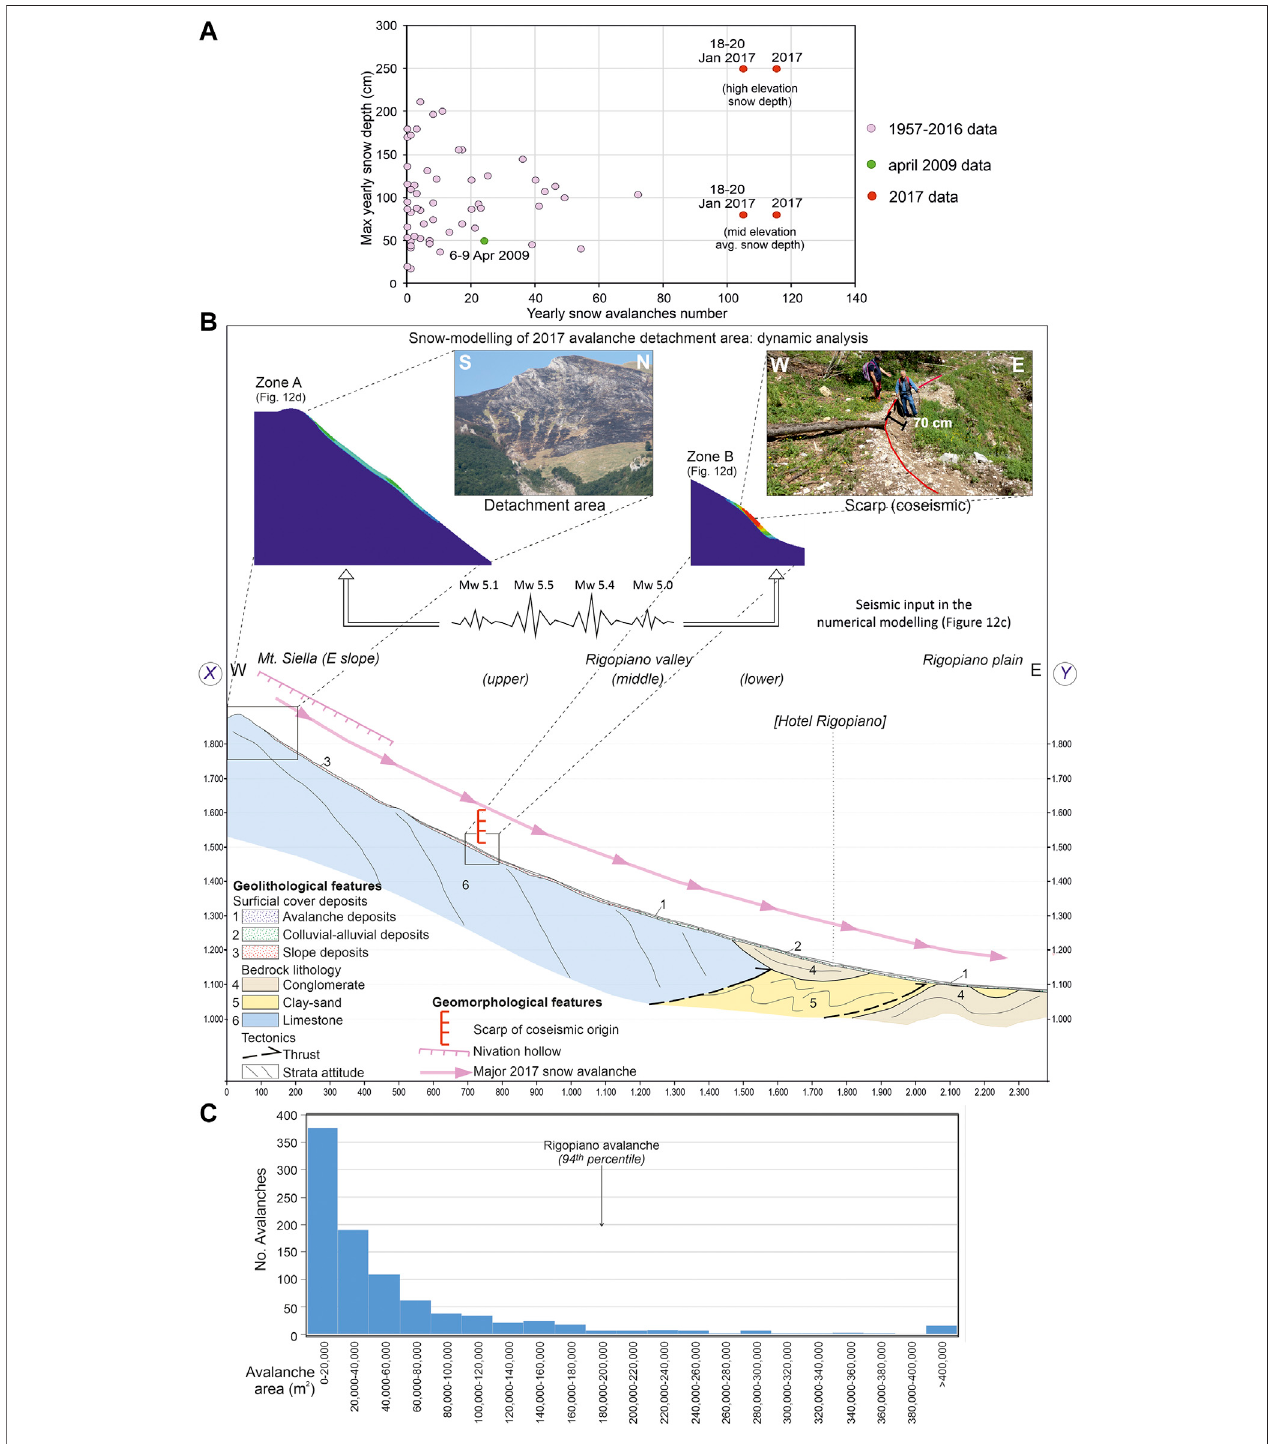
FIGURE 14 | (A) Yearly avalanches distribution vs. maximum snow cover depth. (B) Schematic longitudinal cross-section of the post-2017 avalanche conditions along the Rigopiano valley (location in Figure 10 ), comparing geolithological and geomorphological features, and avalanche modeling of the detachment area. (C) Frequency histogram of the avalanches ’ area from the 1957 – 2017 dataset.